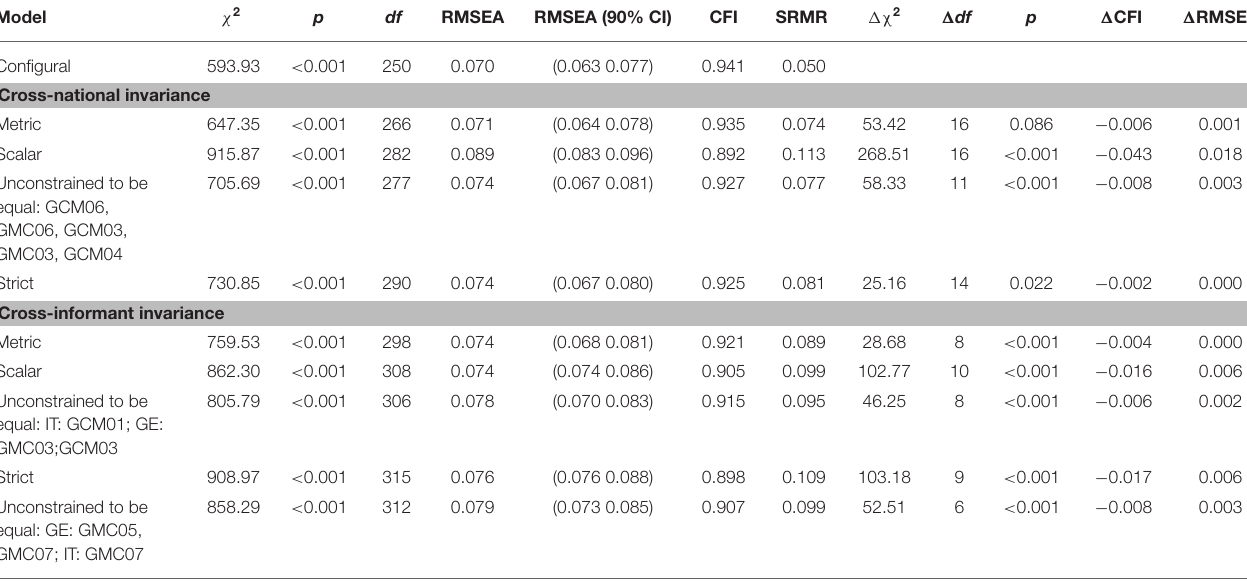
TABLE 3 | Cross-national and cross-informant invariance of the similarity model for the given support mother–child relationship.